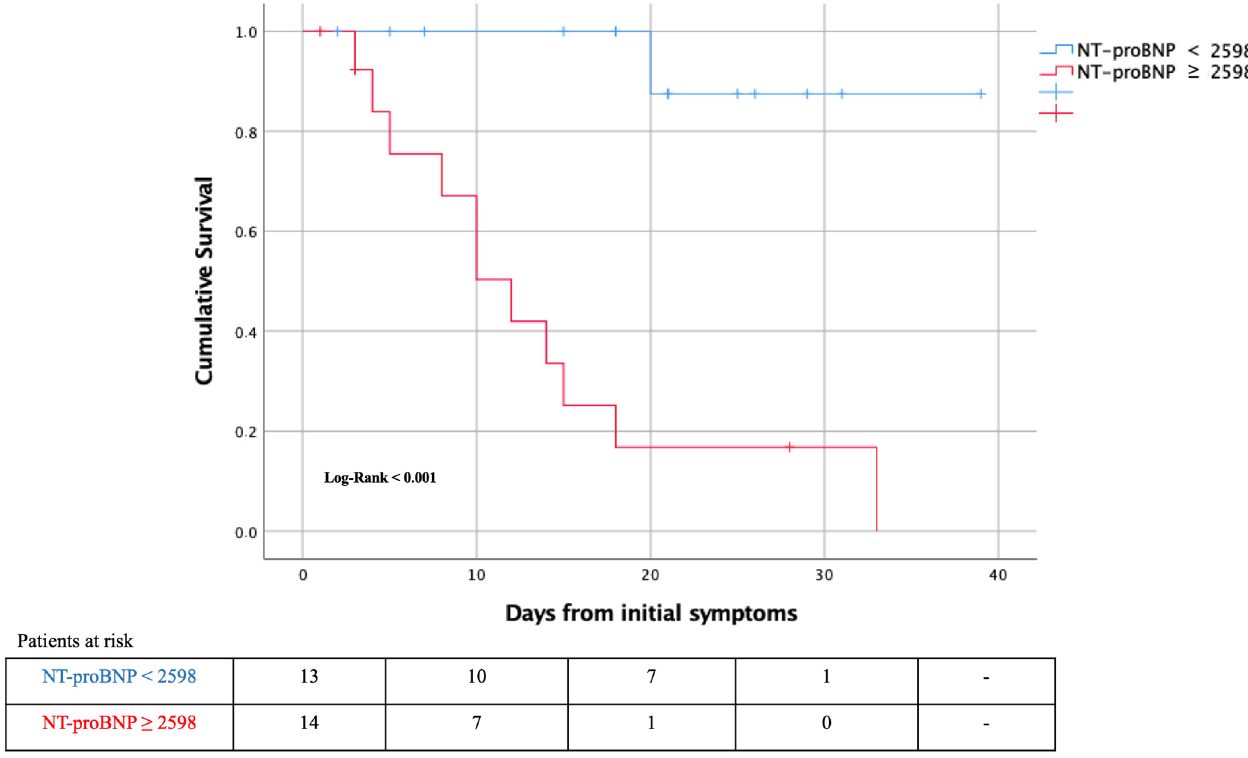
Figure 4. Kaplan–Meier 30-day survival curve for mortality by NT-proBNP during time from initial symptoms.